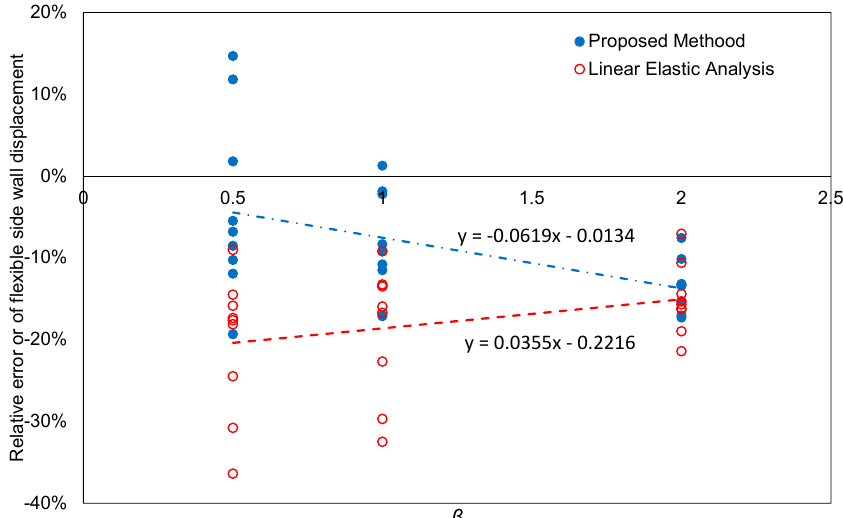
Figure 19. Comparison between the relative errors of the flexible side wall maximum displacement computed by the two methods with respect to α .